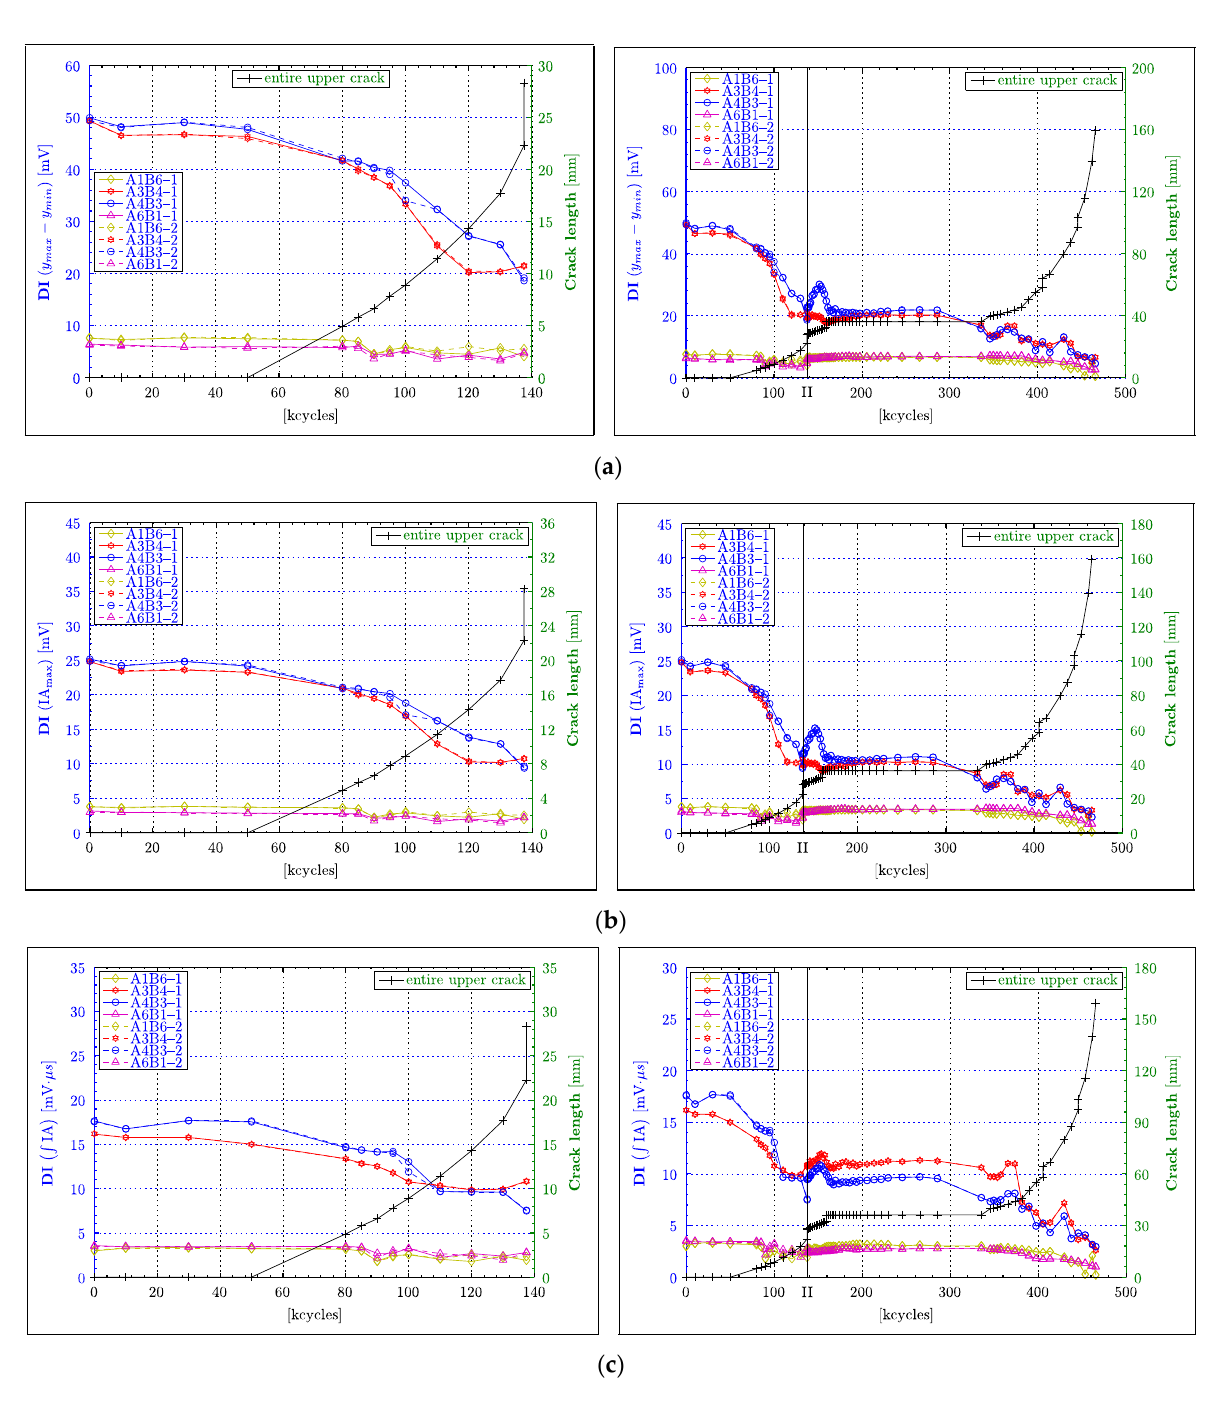
Figure 7. Crack detection results for the CENTRAL wave propagation paths. Damage indices are based on: ( a ) maximum peak-to-peak amplitude; ( b ) maximum instantaneous amplitude (envelope); ( c ) integrated instantaneous amplitude. The left column gives the results corresponding to only the PHASE 1 experimental test (from 0 to 147,500 fatigue cycles only) whereas the right column presents the results for the PHASE 1 and PHASE 2 experimental tests. The thin vertical solid line (described by the symbol “II”) separates the two experimental tests (PHASE 1 and PHASE 2) investigated.